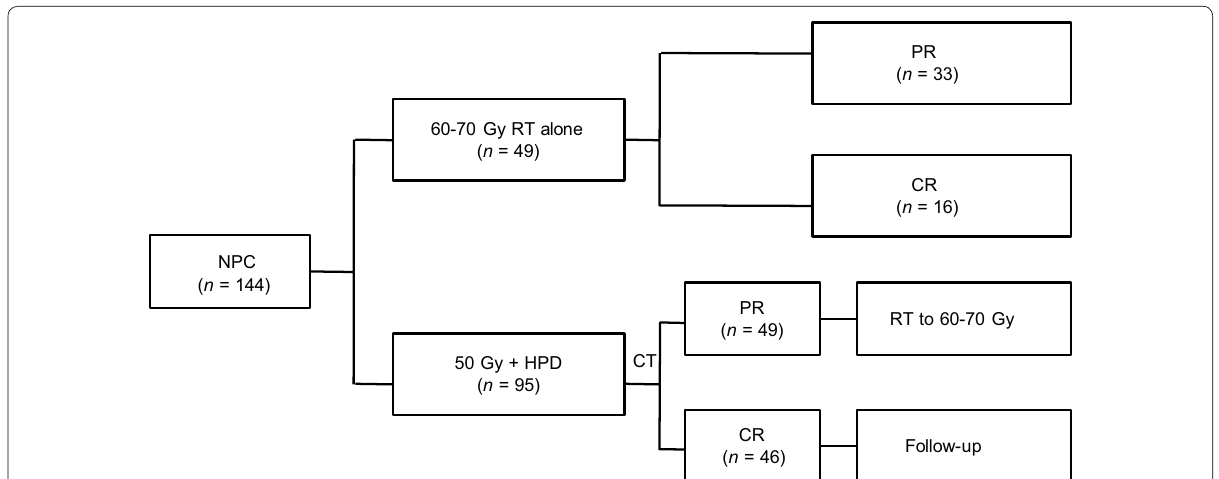
Fig. 1 Flow chart of nasopharyngeal carcinoma (NPC) patient selection. RT radiotherapy; HPD hematoporphyrin derivatives; CT computed tomog‑ raphy; PR partial response; CR complete